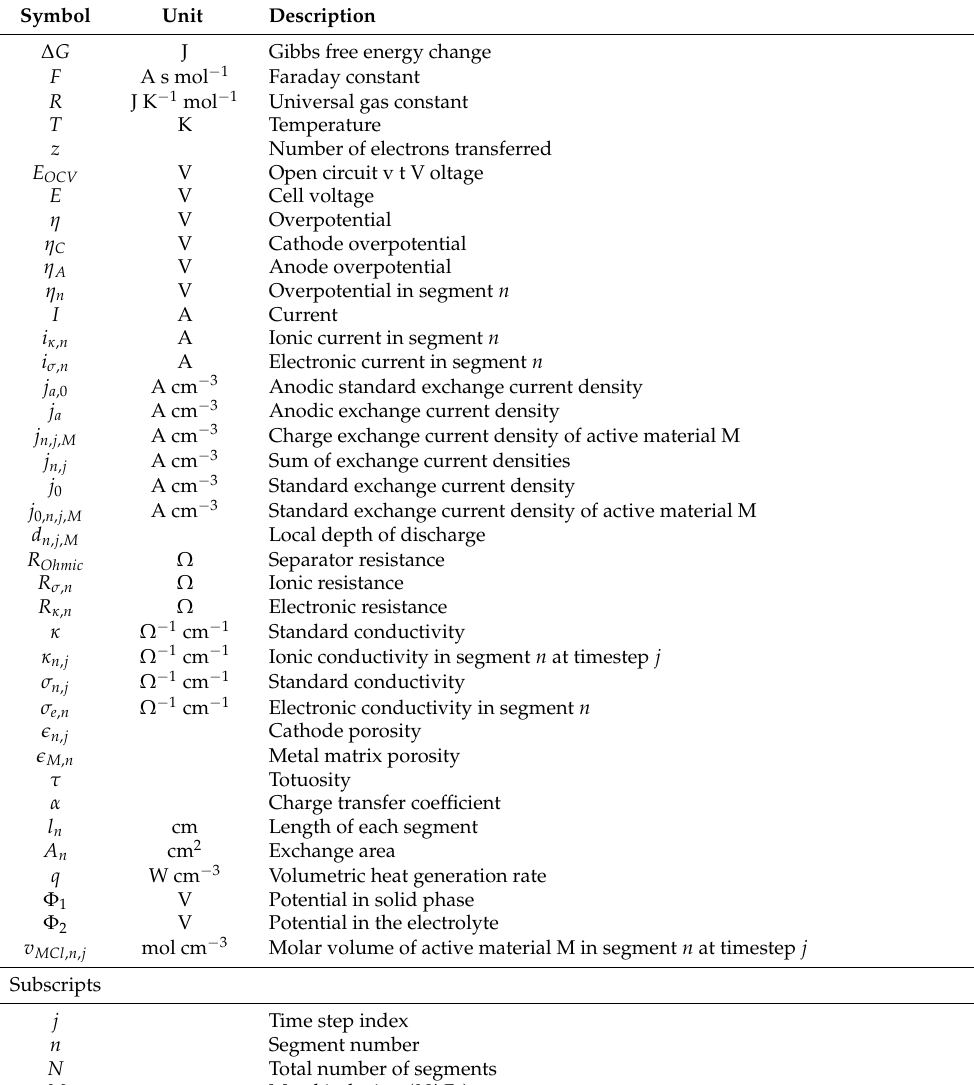
Table 2. List of